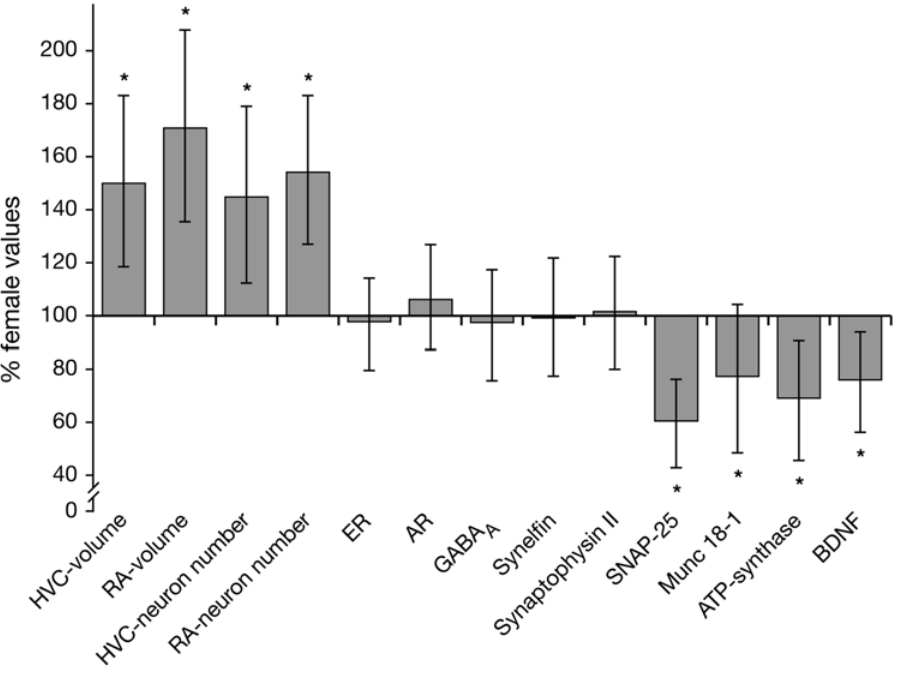
Figure 3. Bi-directional dimorphisms of gross-morphological features (area volume, neuron number) and gene expression of vocal control areas. Data are calculated as male percentages of their female mate (blotted: mean 6 SD of all pairs (n=10)). Clearly, the anatomical features (HVC and RA volume and neuron numbers) are much larger in the male, while the expression level of some genes (SNAP-25, Munc-18-1, ATPsynthase, BDNF) is much higher in the female than in the male HVC. *=p-values , 0.01 (see text for details).